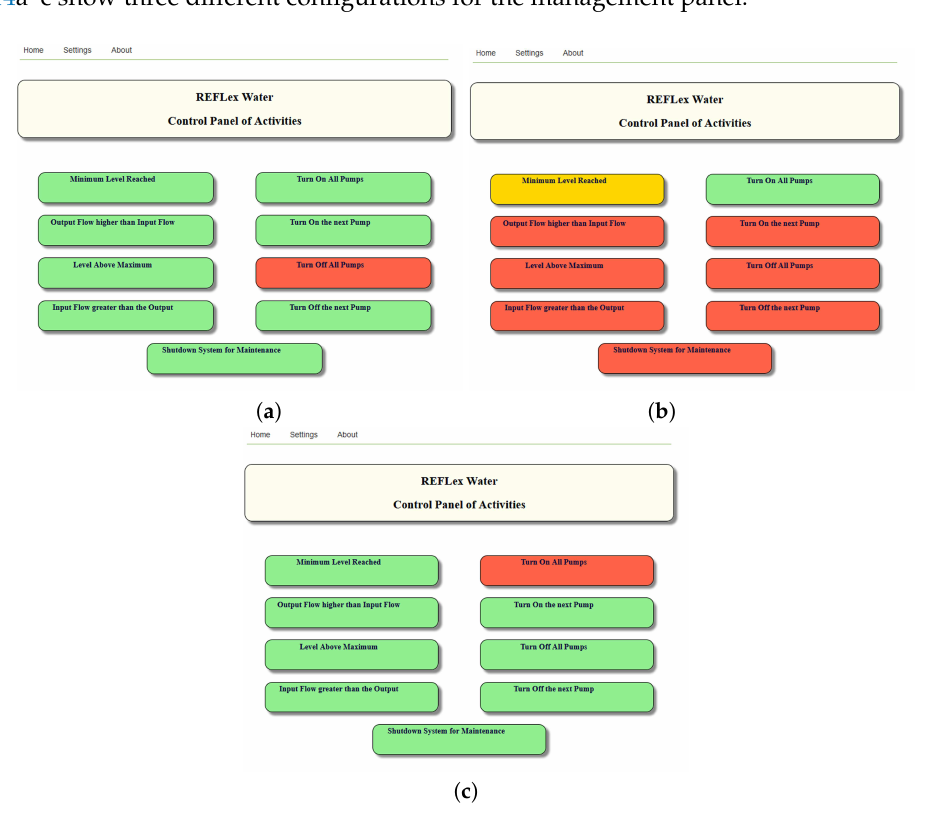
Figure 14. Water Management Interface: ( a ) initialization of system; ( b ) minimal level reached; ( c ) disabled Turn On All